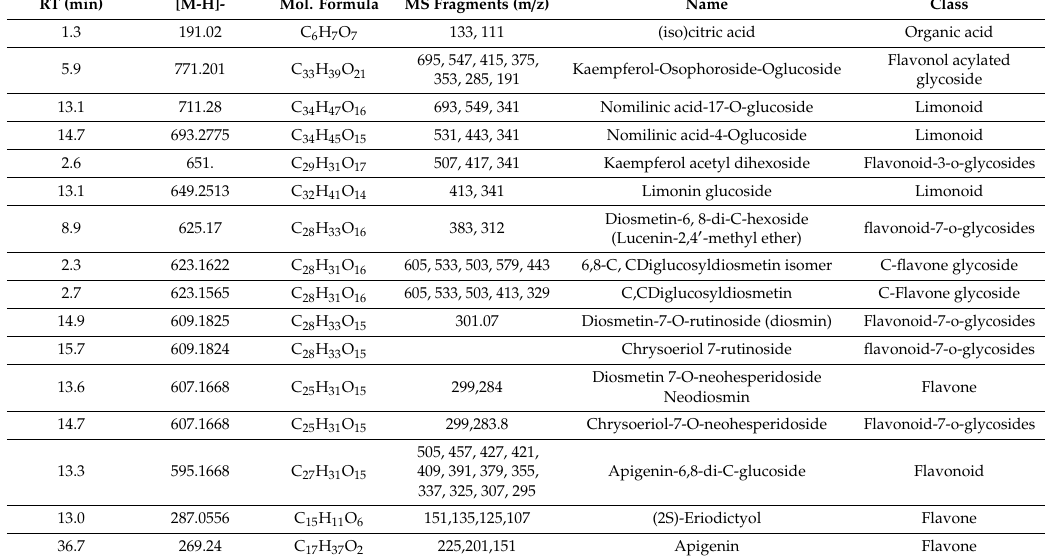
Table 2. List of compounds found in lemon extract using HPLC /